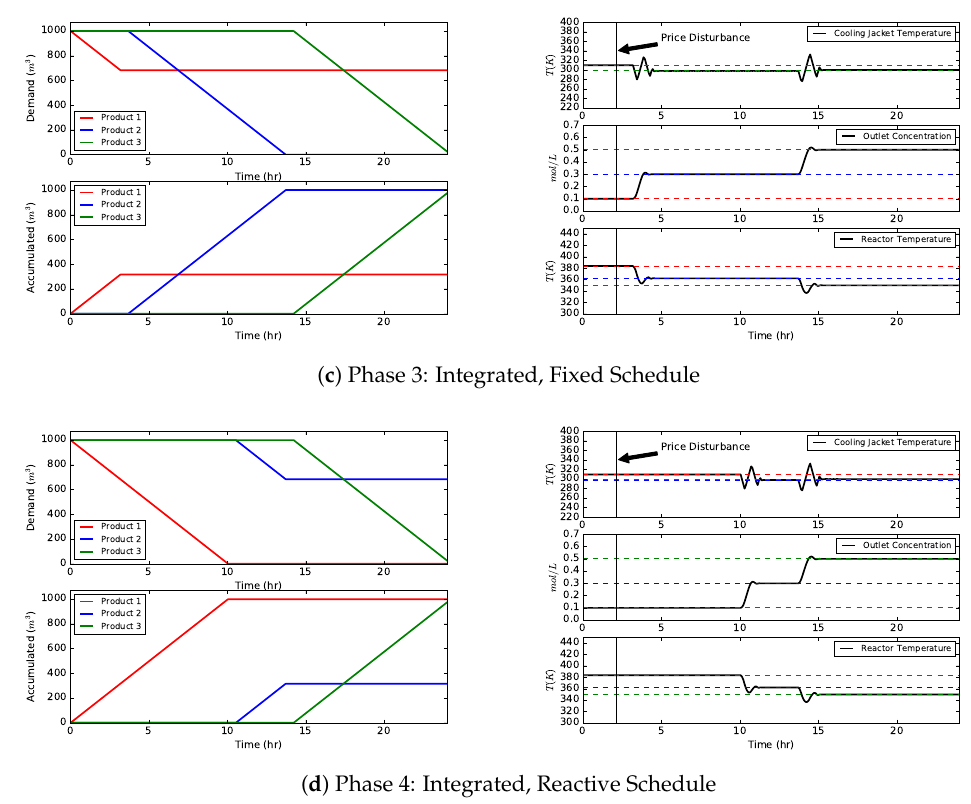
Figure 7. Scenario C: Market update (price